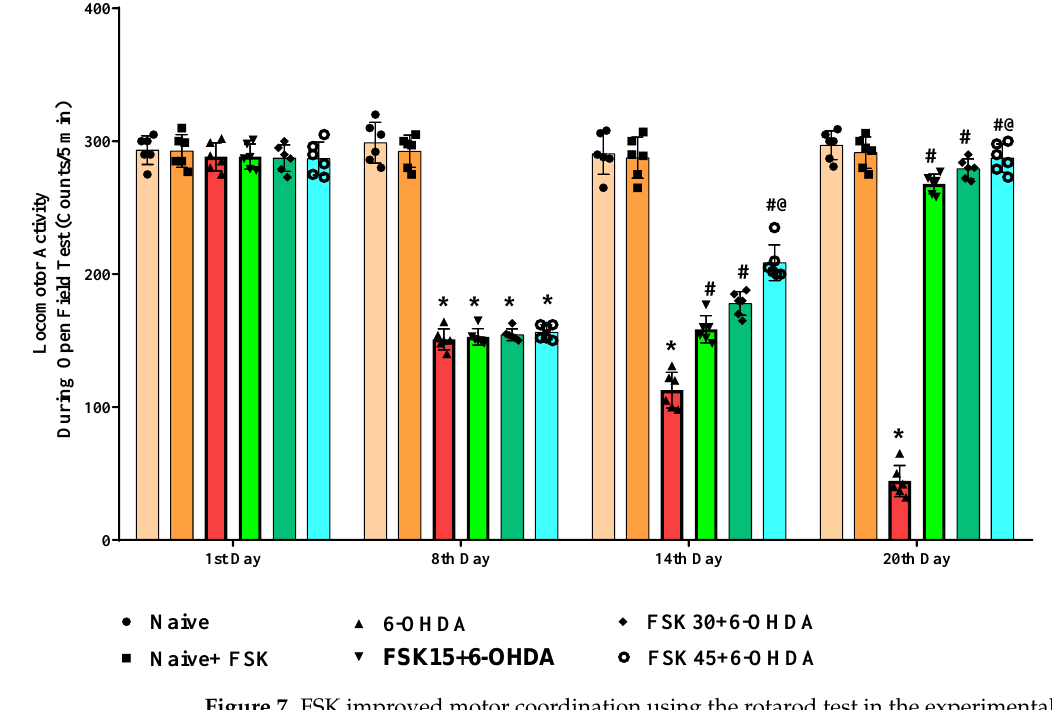
Figure 7. FSK improved motor coordination using the rotarod test in the experimental model of PD. Data provided as mean ± SD (n = 6 ) followed by ANOVA (two-way) with post-hoc Bonferroni test. * 6-OHDA ( p < 0.01) compared with naive and naive + FSK ; # FSK15, FSK30, FSK45 (p < 0.01) compared with 6-OHDA ; #@ FSK45 (p < 0.01) compared with FSK30, FSK15.